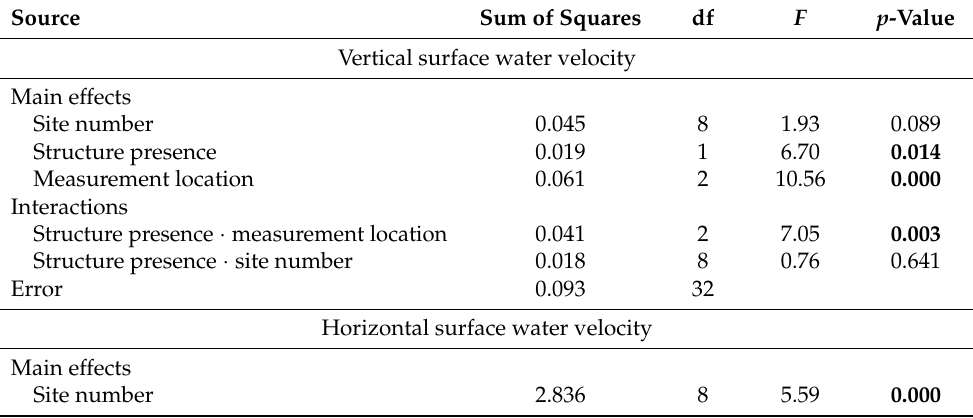
Table 2. Three-way analysis of variance results of vertical and horizontal surface water velocity on the lower Mokelumne River. The effects of site number (1–9), in-channel structure presence (Yes versus No), measurement location (upstream, lateral, and downstream) and interactions of the main effects were tested. Bold indicates statistical significance ( p <